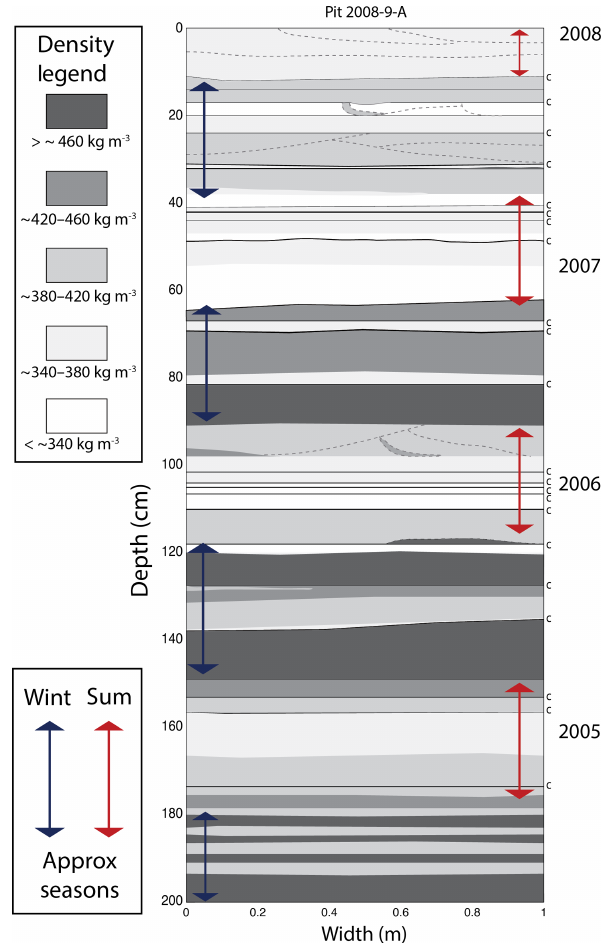
Figure 13. A detailed view of data for snow pit 2008-09-A, includ- ing wall map, density profile, annual layer picks, and crust occur- rences. Density, layering, and feature preservation are again noted as in Fig. 12. Individual crusts are identified with a labeled “c” along the vertical axis. Seasonal accumulation layers were “picked” visu- ally in the pit (shown with red and blue arrows). These observations indicate a somewhat regular pattern of equally distributed yearly accumulation at WAIS Divide with clear annual